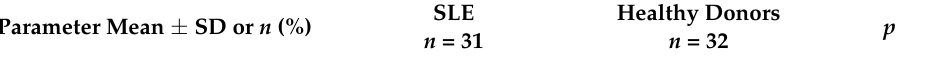
Table 1. Clinical and laboratory parameters for patients with systemic lupus erythematosus (SLE) and healthy donors